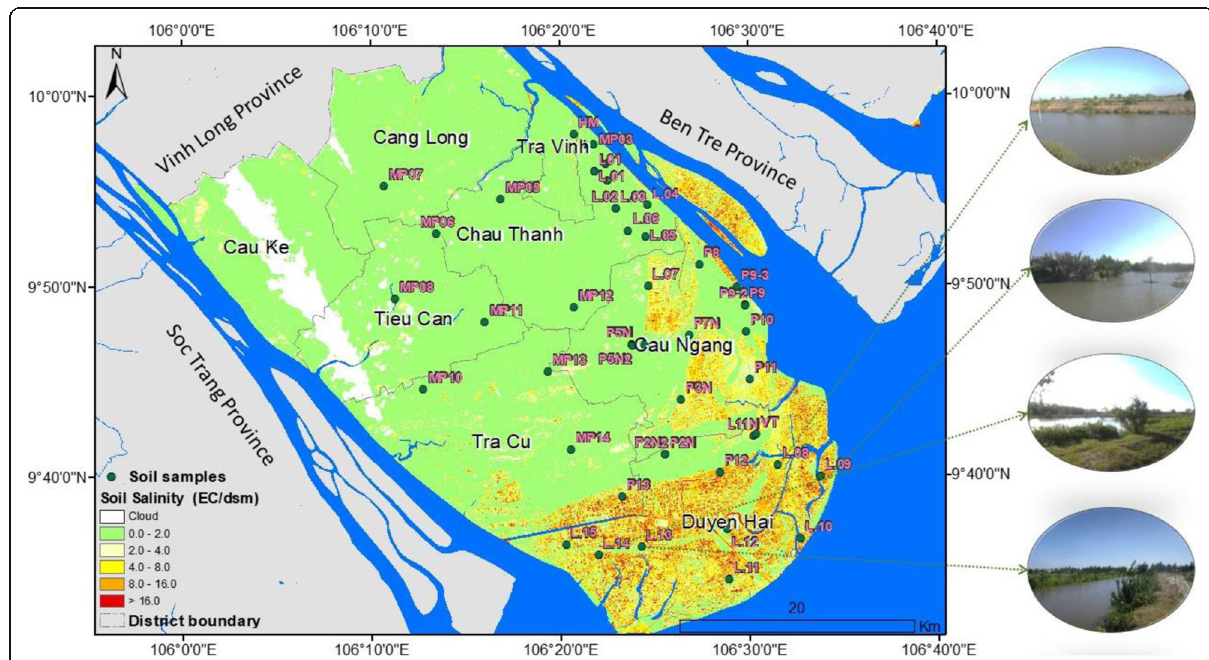
Fig. 10 Soil salinity map with depth from 0 cm to 20 cm in Tra Vinh Province, derived from Landsat 8 OLI using NIR channel (equation 1 in Table 3). Soil samples are displayed on the map with in situ photos (right) showing land cover conditions. The numbering of the locations is to classify the soil sample site, while the initial letters, M, P, and L indicate the names of the person who took the soil